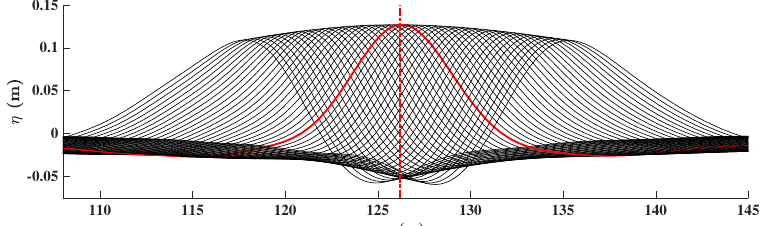
Figure 17. The wave profiles along the longitudinal direction of the wave tank with the wave steepness (cid:101) p = 0.0646 are plotted in one graph at an interval of 0.06 s near t = 103.0 s. The red dash-dot line indicates the real focusing location in the NWT at x = 126.21 m, which aligns with the designated focusing locations.